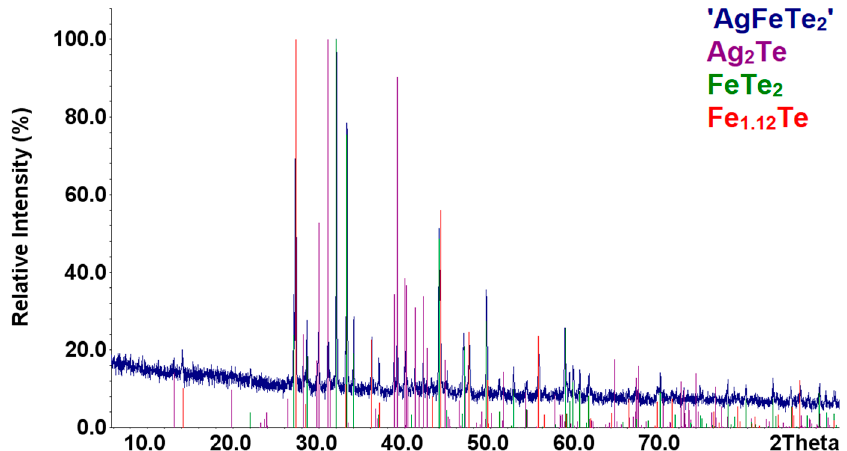
Figure 1. Comparison of the XRD patterns of the sample ‘AgFeTe 2 ′ with those theoretical patterns of the compounds.